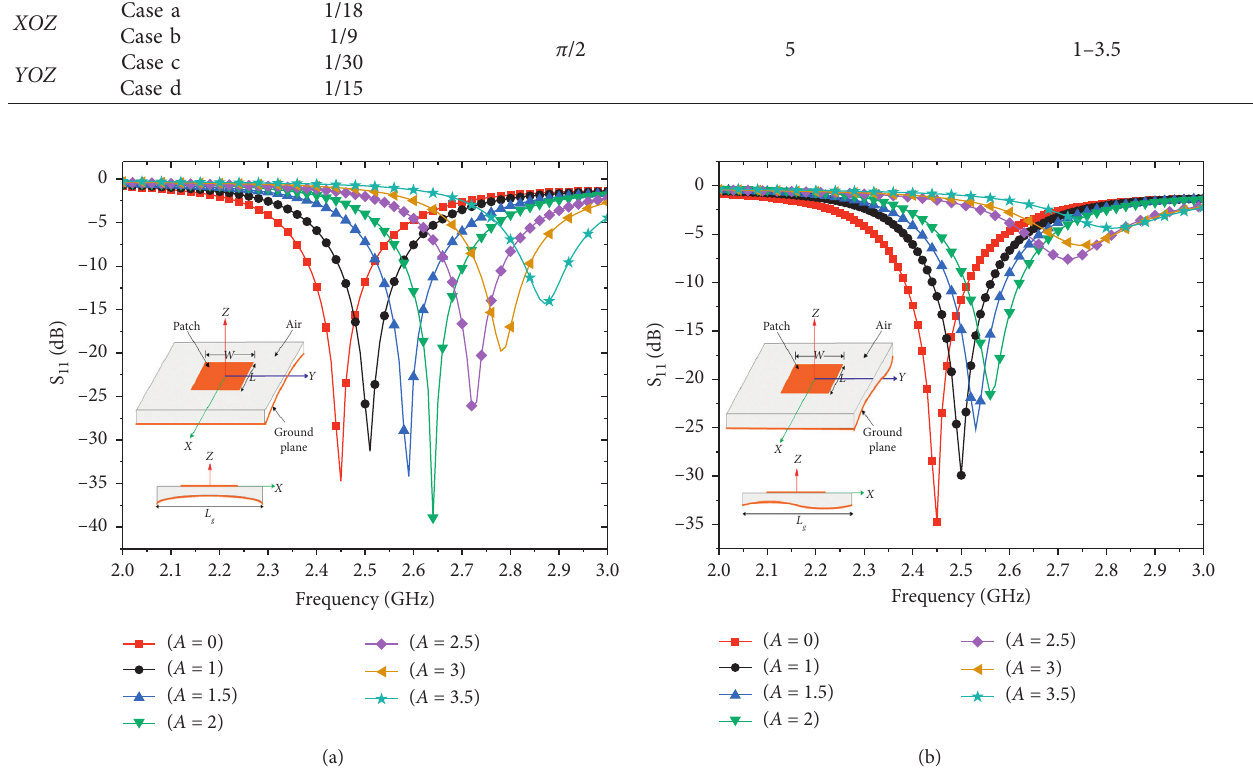
Figure 4: The variation of S parameter with the deformation amplitude A of XOZ plane. (a) Case a and (b) case